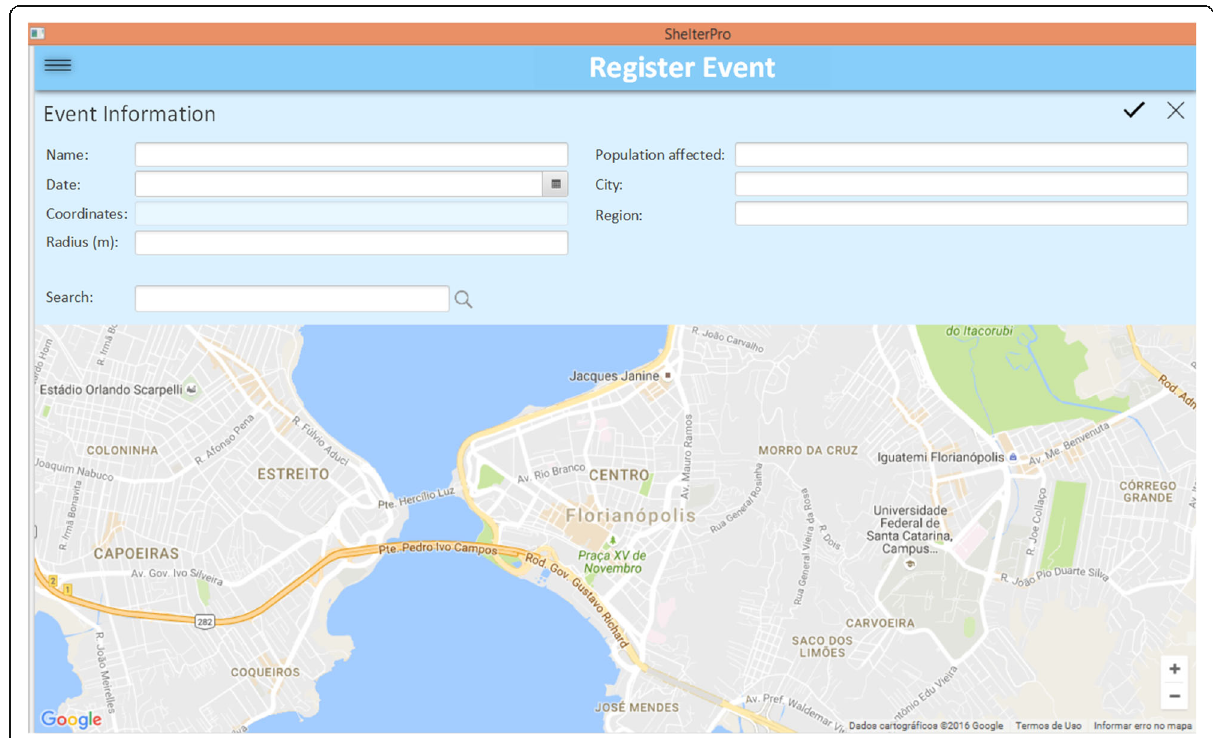
Fig. 6. ShelterPro registration of an event